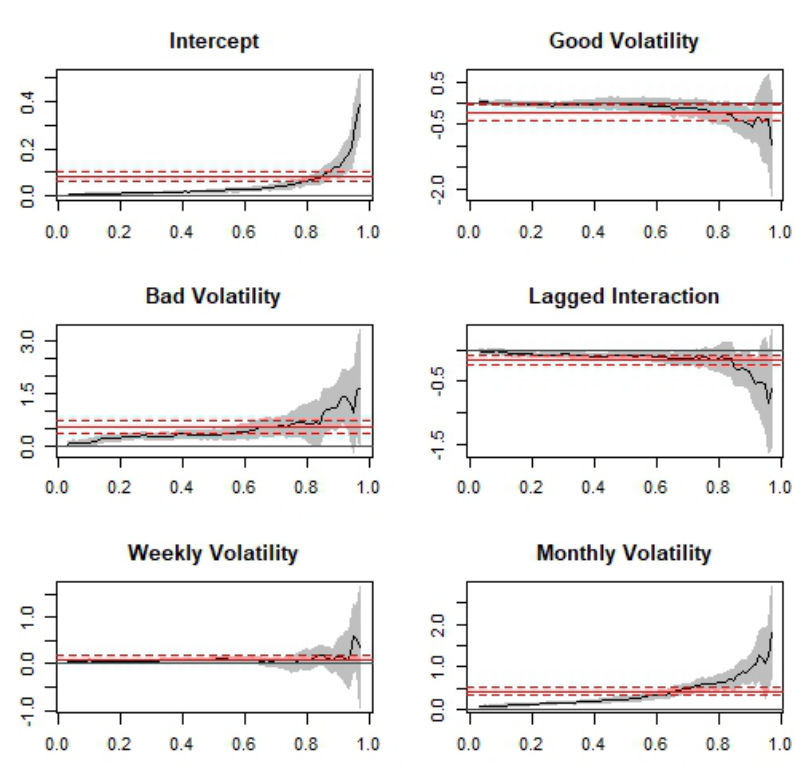
Figure 8. Model 5: HAR-RV-QR results—7-day